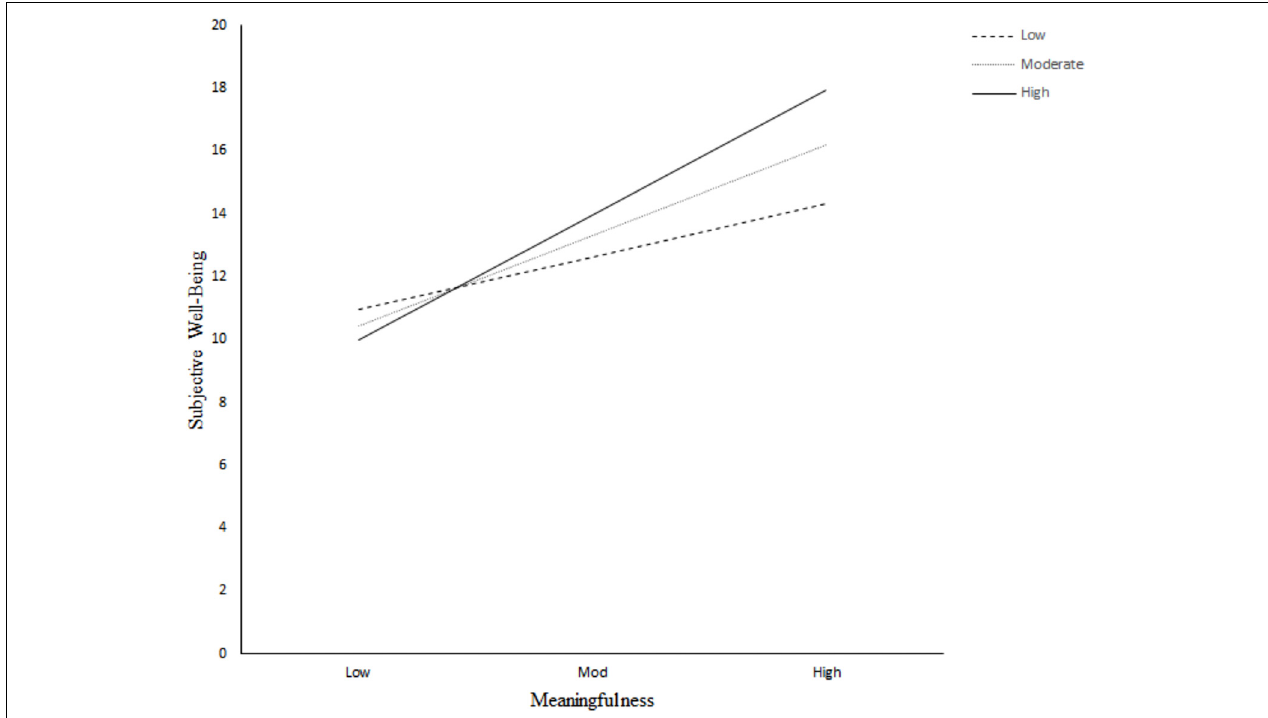
FIGURE 3 | Conditional effect of meaningfulness on subjective well-being for low, moderate, and high levels of the trait self-control in the Intellectually Gifted Group.